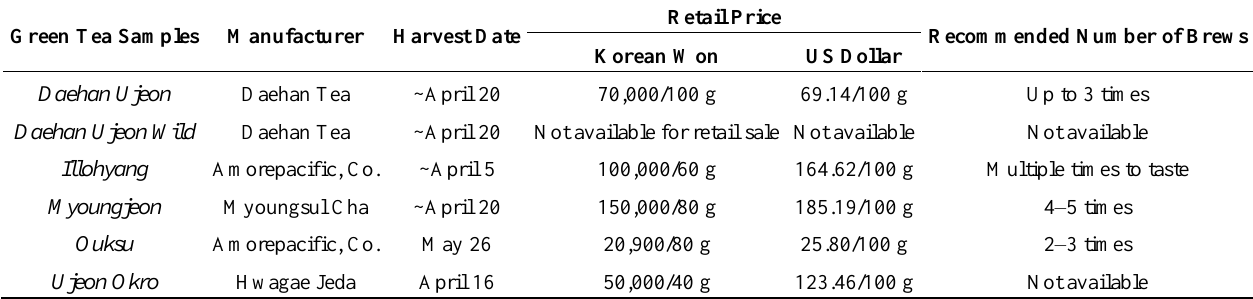
Table 1. Product name, manufacturer, harvest date, and price for green tea samples evaluated. Green Tea